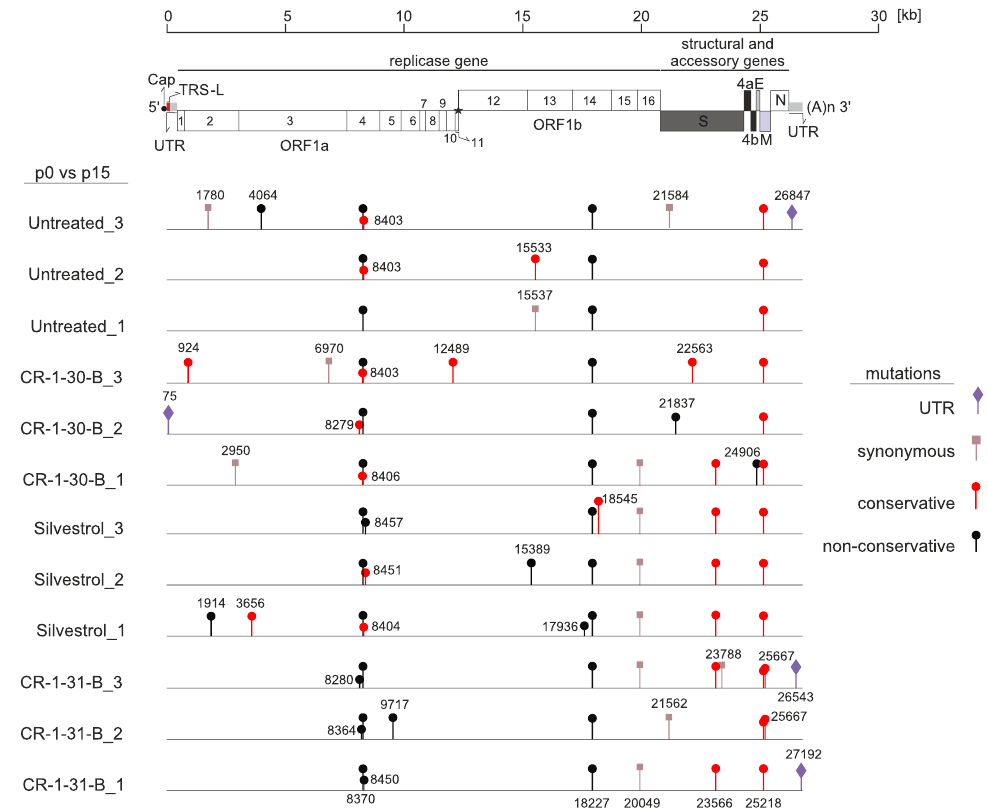
Figure 2. Genetic comparison of input HCoV-229E virus genomes (p0) to obtained p15 virus isolates treated with different rocaglates. CR-1-30-B, the inactive enantiomer of CR-1-31-B, served as a control. MRC-5 cells were infected with the input virus (p0) or the 15 times passaged virus isolates obtained in Figure 1. (MOI = 3). Viral RNA was isolated 24 hpi and sequenced. Single-nucleotide changes are indicated at their location in the virus genome (synonymous: light brown; conservative missense: red; non-conservative missense: black).